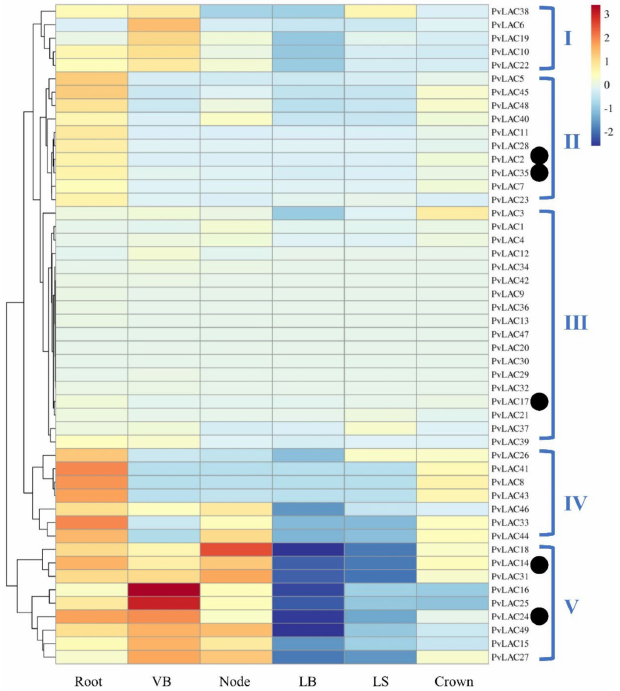
Figure 5. Expression profile of the PvLacs in E4 stage switchgrass. The detailed expression data were obtained from JGI Plant Gene Atlas